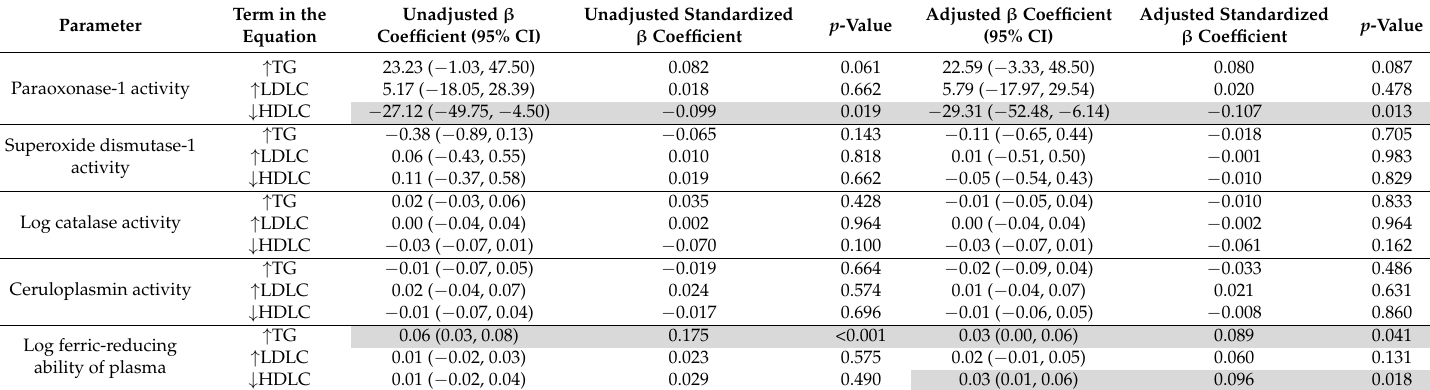
Table 3. Results from the linear regression models considering the main effects of the components of lipid profile and their association with the activity of antioxidant enzymes and FRAP.